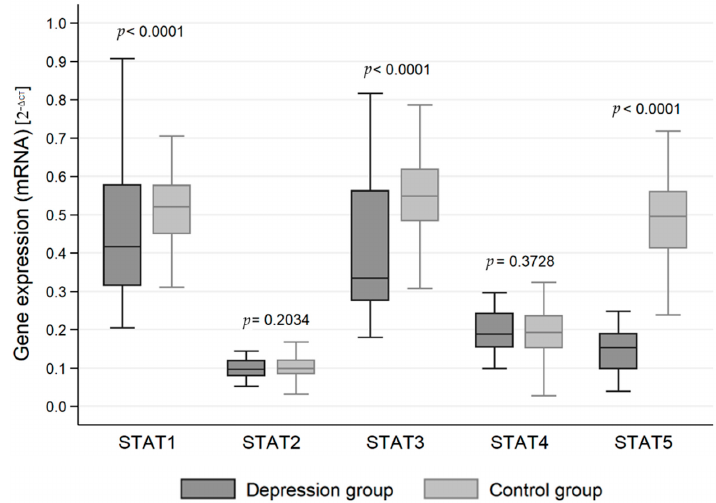
Figure 2. Expression of signal transducer and activator of transcription (STAT) protein family genes at the mRNA level in the depression and healthy control group.